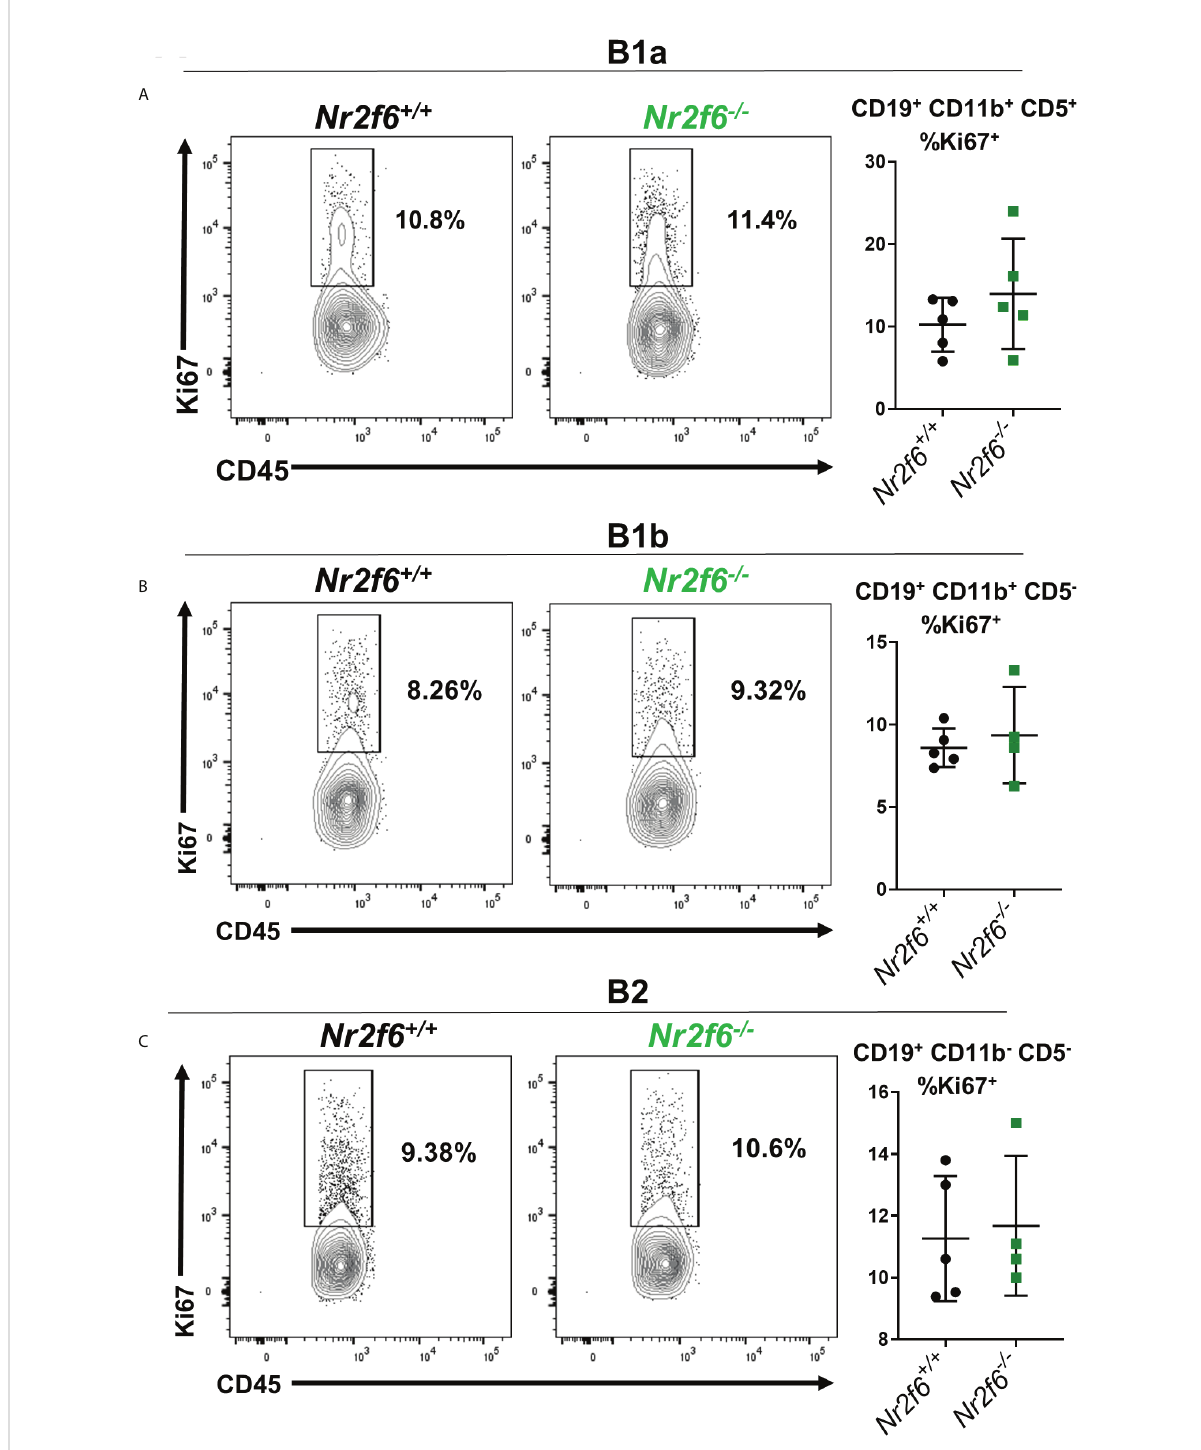
FIGURE 6 Nr2f6 -/- peritoneal B cells exhibit similar Ki67 staining as wild-type cells. Intracellular Ki67 staining was performed ex vivo on (A) B1a, (B) B1b and (C) B2 cells, isolated from mice of the indicated genotype B cell populations were de fi ned using CD19, CD11b and CD5. The left panels display representative fl ow cytometry plots and graphs (right side) show the percentage of each population staining positively for Ki67 from all experiments. Data shown are derived from two individual experiments with at least two mice. Each data point represents an individual mouse. Statistical signi fi cance was determined using a two-tailed student t-test, data were not signi fi cantly different between the